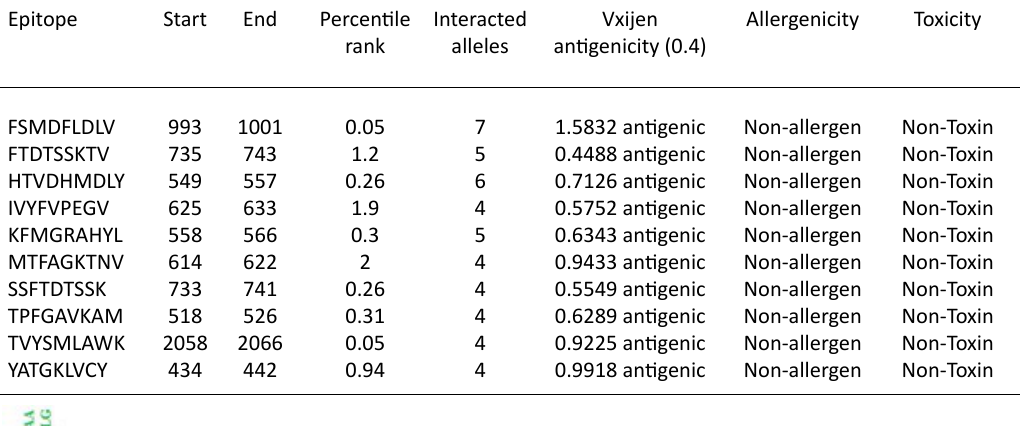
Table 2. The predicted T cytotoxic cells epitopes, their antigenicity, allergenicity, toxicity from AEV polyprotein Epitope Start Percentile